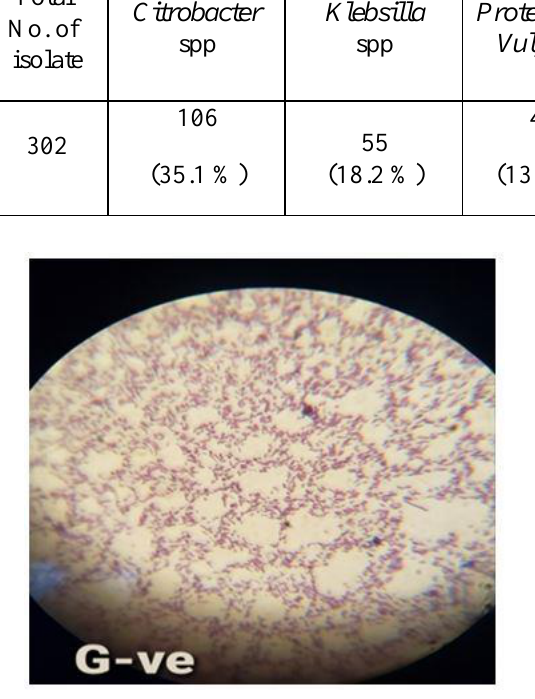
Fig. 3: Gram stain of Citrobacter